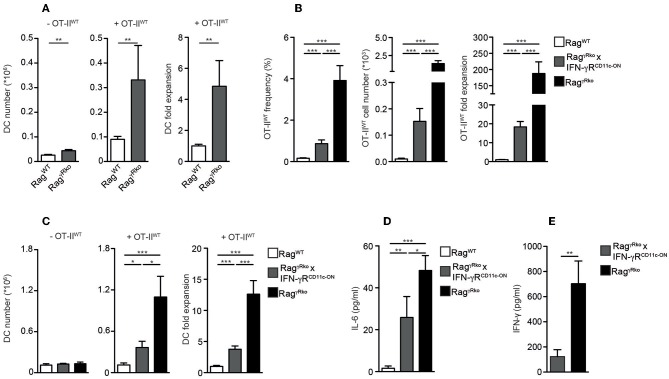
IFN-γR+ DCs restrain CD4+ T cell SP in RagγRko mice. (A–D) OT-IIWT cells were adoptively transferred into RagWT and RagγRko mice. After 11–13 days, recipient splenocytes were analyzed by flow cytometry. (A) Results of 2–6 independent experiments with a total of 10–25 mice were pooled to calculate the numbers and fold expansion of CD11c+MHCIIhi DCs after reconstitution with OT-IIWT cells (+OT-IIWT). DC numbers from untreated RagWT and RagγRko mice were determined as well (-OT-IIWT). (B–D) Frequencies, cell numbers and fold expansion of OT-IIWT cells/DCs as well as plasma IL-6 levels were analyzed in RagWT, RagγRko × CD11c-GCDL × IFN-γRSO (RagγRko × IFN-γRCD11c−ON) and RagγRko mice. Pooled results of 2 independent experiments with a total of 8 mice per group are shown. (E) Steady-state levels of IFN-γ were determined in plasma samples of 8–9 untreated RagγRko × IFN-γRCD11c−ON and RagγRko mice. (A–E) Graphs show mean values + SEM; *p ≤ 0.05; **p ≤ 0.01; ***p ≤ 0.001.